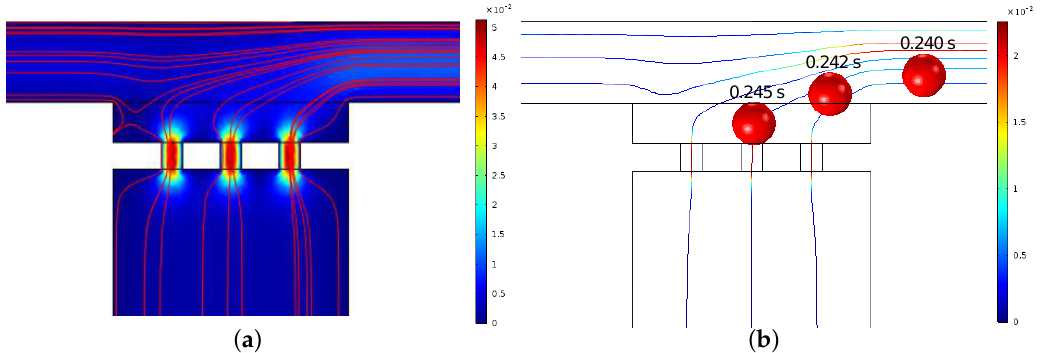
Figure 6. ( a ) Velocity distribution and streamlines around the micropipette aspiration channels for N = 3. ( b ) Tracking trajectory of a particle at different time